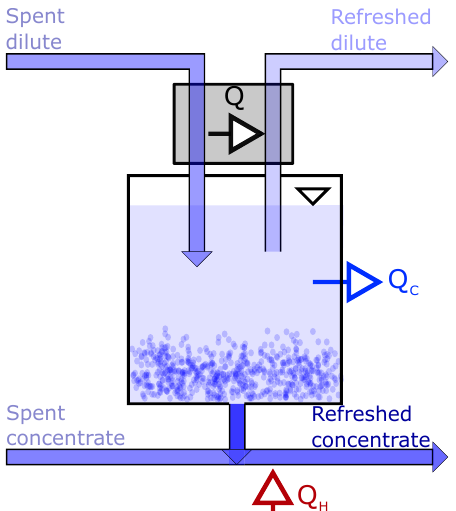
Figure 2. Illustration of the thermal separation unit (in Figure 1) using precipitation. Thermal energy is removed from the spent dilute solution (Q C ), to precipitate salt. Thermal energy (Q H ) is added to the spent concentrated solution after the salt slurry is